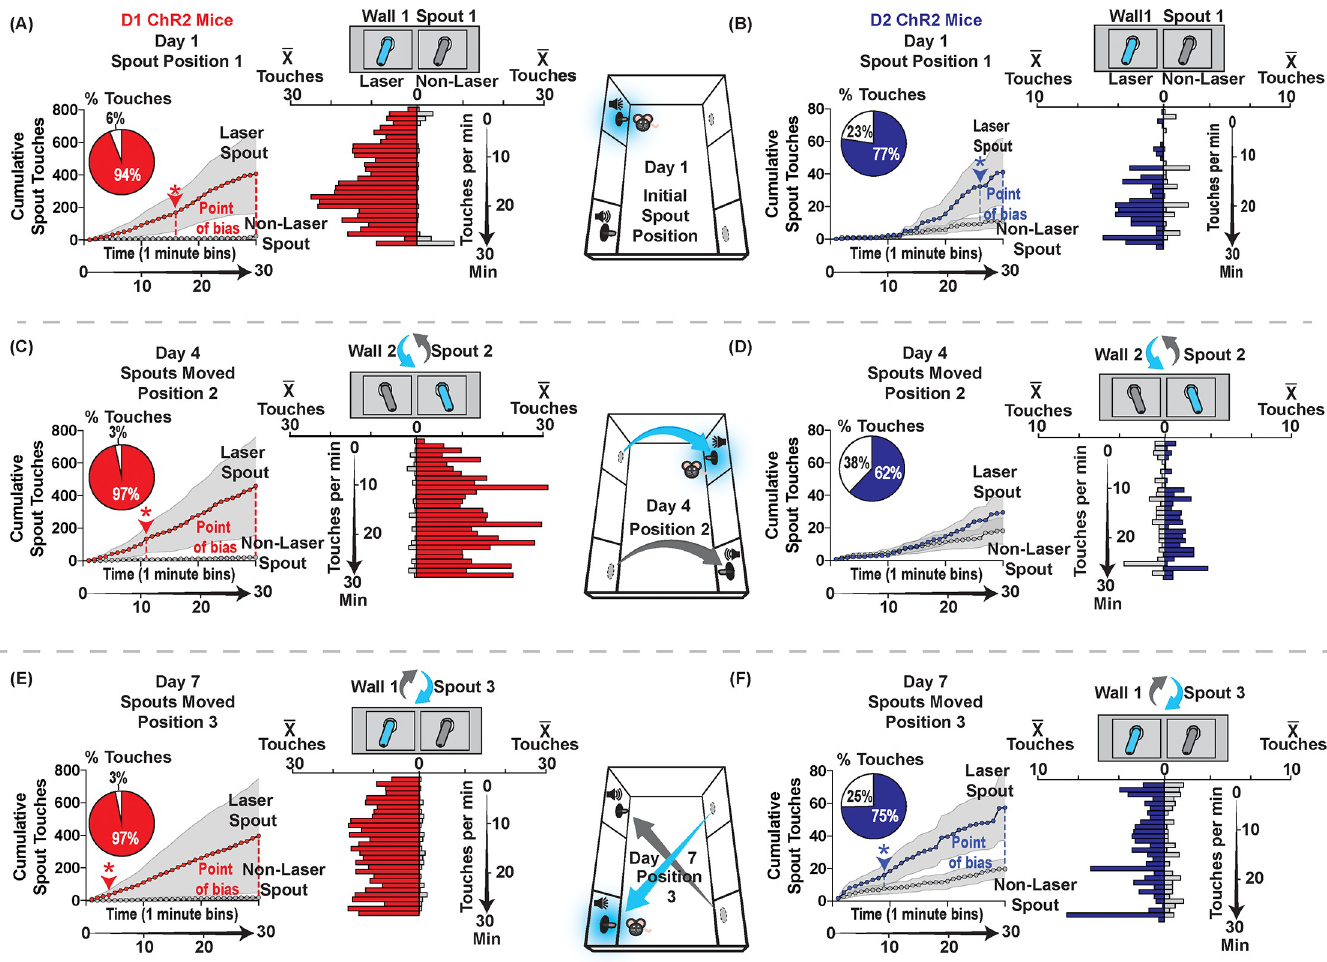
Fig 2. Tracking new positions: Minute-by-minute spout contacts by ChR2 mice on Day 1, Day 4 and Day 7. Responding for laser stimulation of NAc MSNs for D1 ChR2 mice (left side; n = 9) and D2 ChR2 mice (right side; n = 9) for Day 1 ( A-B ), Day 4 ( C-D ), and Day 7 ( E-F ) is shown as minute-by-minute touches (descending horizontal bars) and cumulative responding (line graph). Laser location (Position 1, 2, 3) for each day is shown in center diagram for each day and above each minute- by-minute bar graph. Touches per minute are shown by descending horizontal bars for each day. Bars projecting towards the laser spout from vertical axis show laser- spout contacts per min (red for D1 mice; blue for D2 mice). Bars projecting towards the non-laser spout from vertical axis show non-laser spout contacts for same min (gray for all mice). Cumulative touches within the day are shown by 2-line graphs at left of bar graph for each day. Point of bias indicates the minute at which cumulative contacts on laser-delivering spout becomes significantly greater than on non-laser spout. Pie charts show the percentage of laser spout contacts vs non-laser spout contacts per day. On Day 1, the position of laser-spout and non-laser spout are new, and D1 mice (A) begin to self-stimulate NAc ChR2 within first two minutes, while D2 mice (B) take about 10 minutes to begin. On Day 4, with new positions on opposite wall, D1 mice (C) again begin within two minutes, while D2 mice (D) take about 10 min to begin. On Day 7, with a third new position for each spout (reversed from Day 1), both D1 (E) and D2 (F) mice begin to self-stimulate within first minute. Data shown are mean ± SEM; � p <